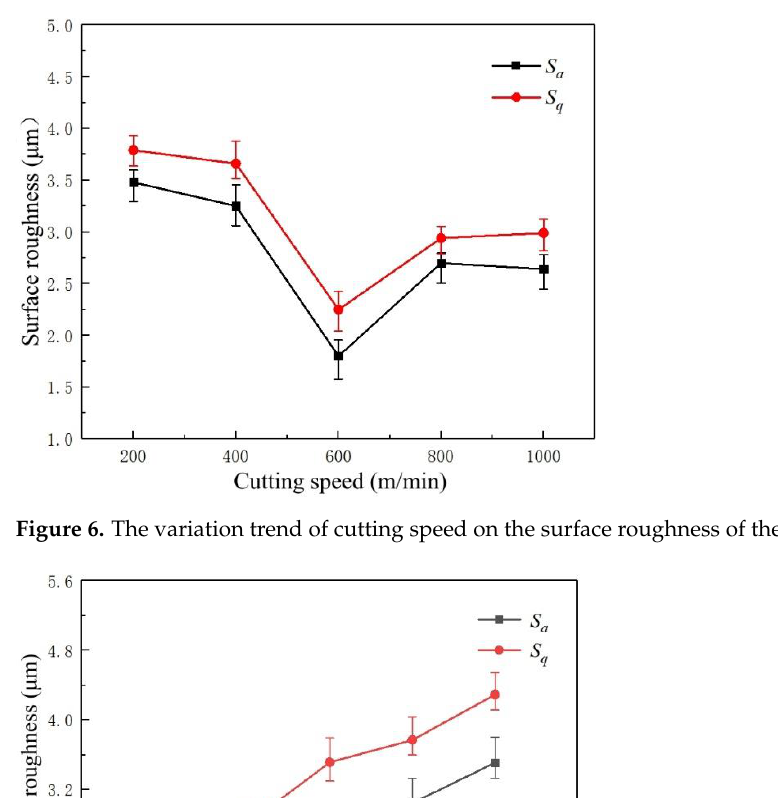
Figure 6. The variation trend of cutting speed on the surface roughness of the machined surfaces.